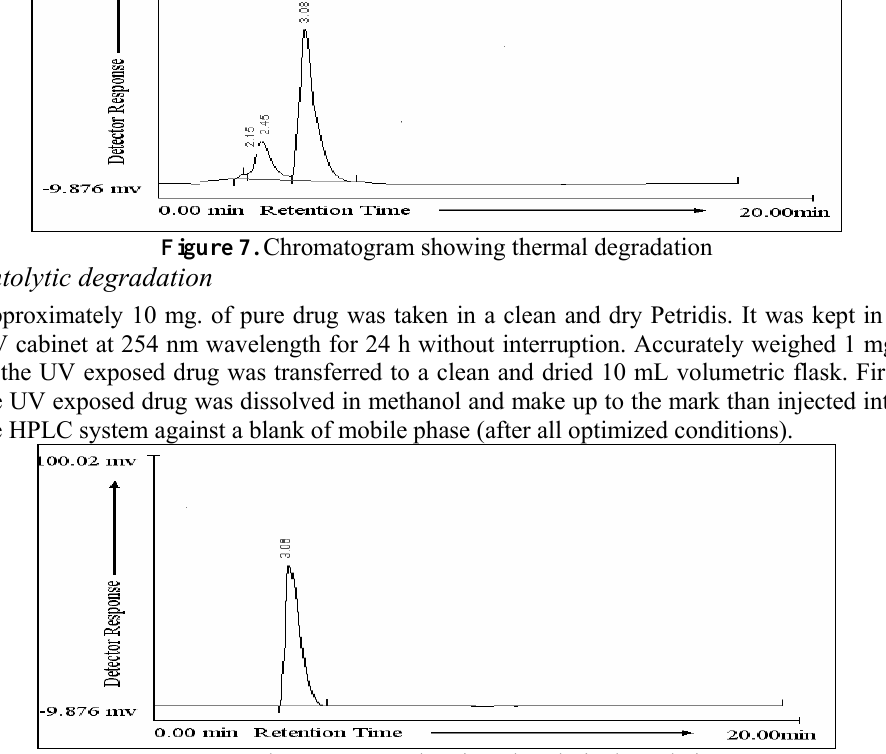
Figure 8. Chromatogram showing photolytic